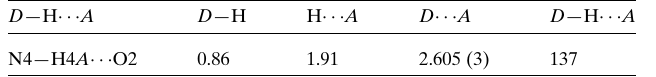
Table 2 Experimental details.